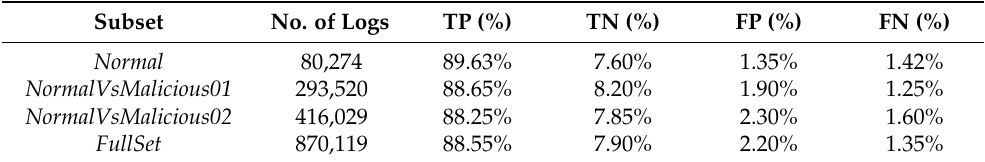
Table 6. Total number of tests performed with PeX per attack and subset, including FP and TP percentages. The evaluation of the depicted logs was executed under the extended rule-based policy, including the “.dll” analysis of Section 6.2.4.